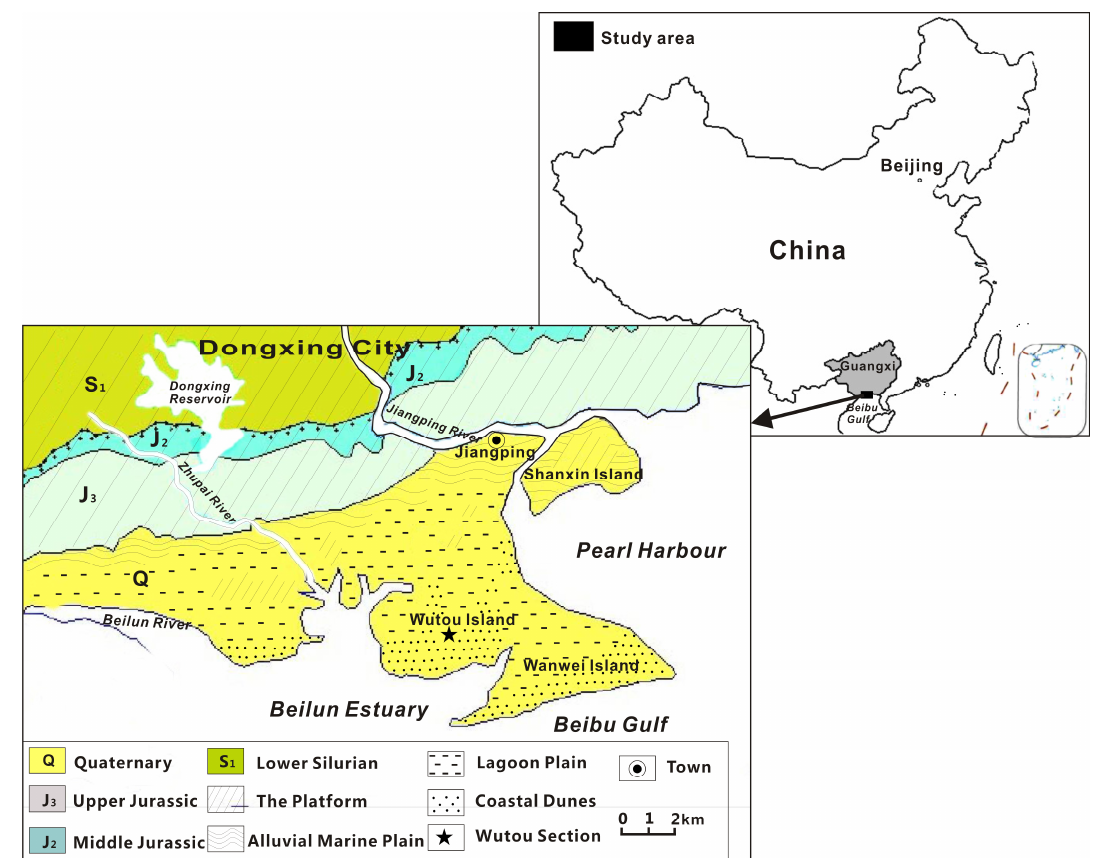
Figure 1. Stratigraphic map of the Wutou section.